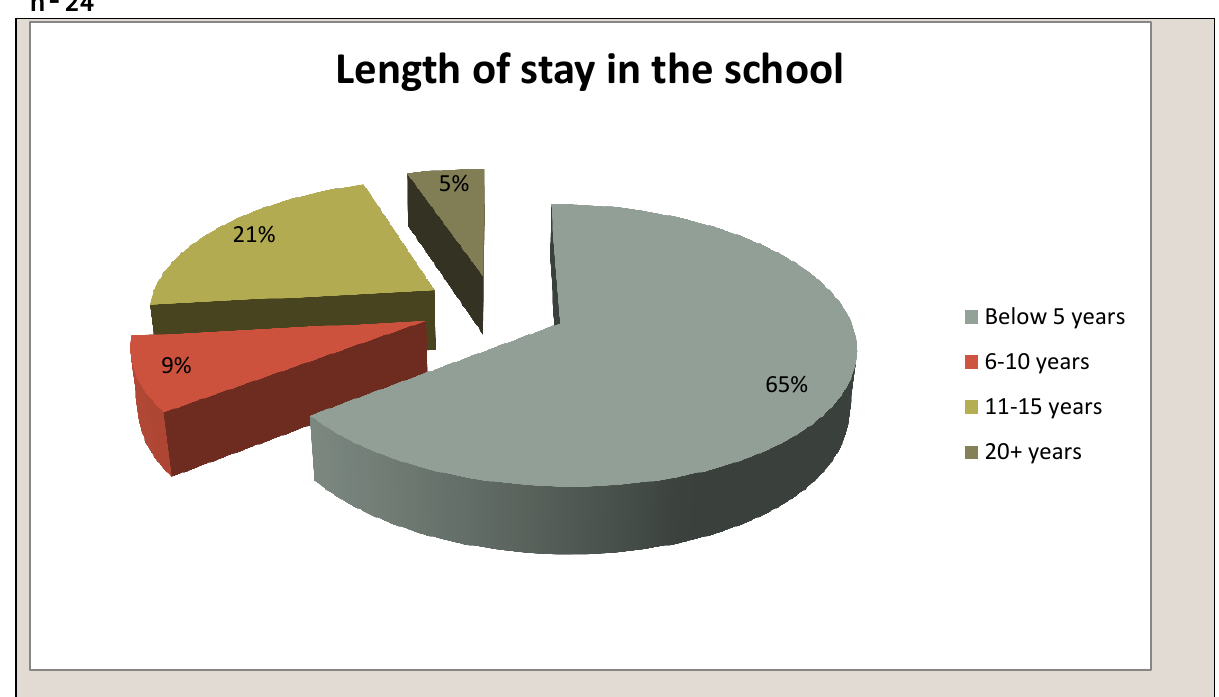
Figure 5.2: The participants’ length of stay at the school (Field data,